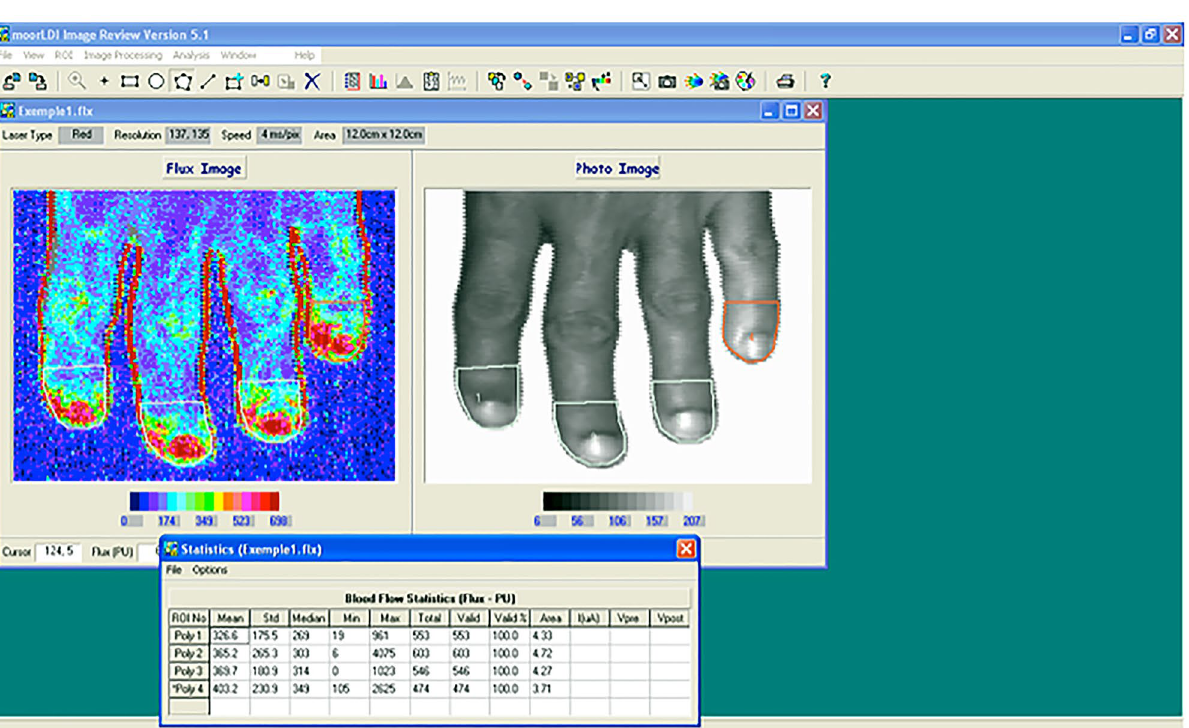
Figure 2. Laser Doppler imaging analysis of the distal phalanx (in this case of a patient presenting optic disc hemorrhage with an intraocular pressure of 18